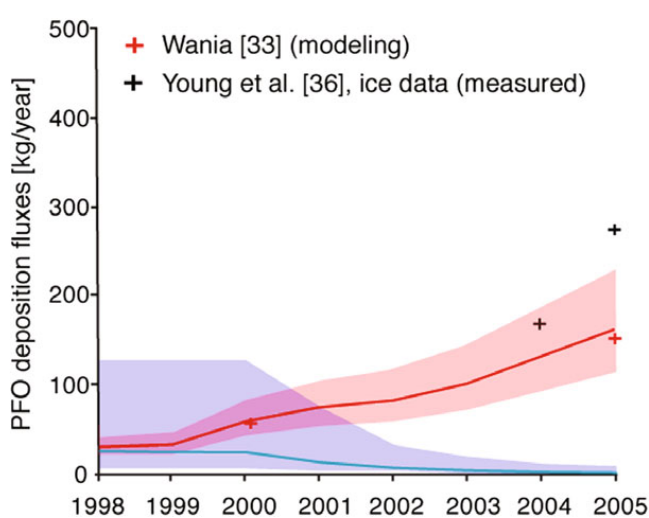
Fig. 5. Deposition of PFOA from the atmosphere to the surface north of 65 ◦ N, in units of kg / year. Black: mea- sured values [36]; red: PFOA formed by degradation of FTOH; blue: PFOA formed by degradation of FOSE. Adapted with permission from Schenker et al. [37]. Copyright 2008 American Chemical